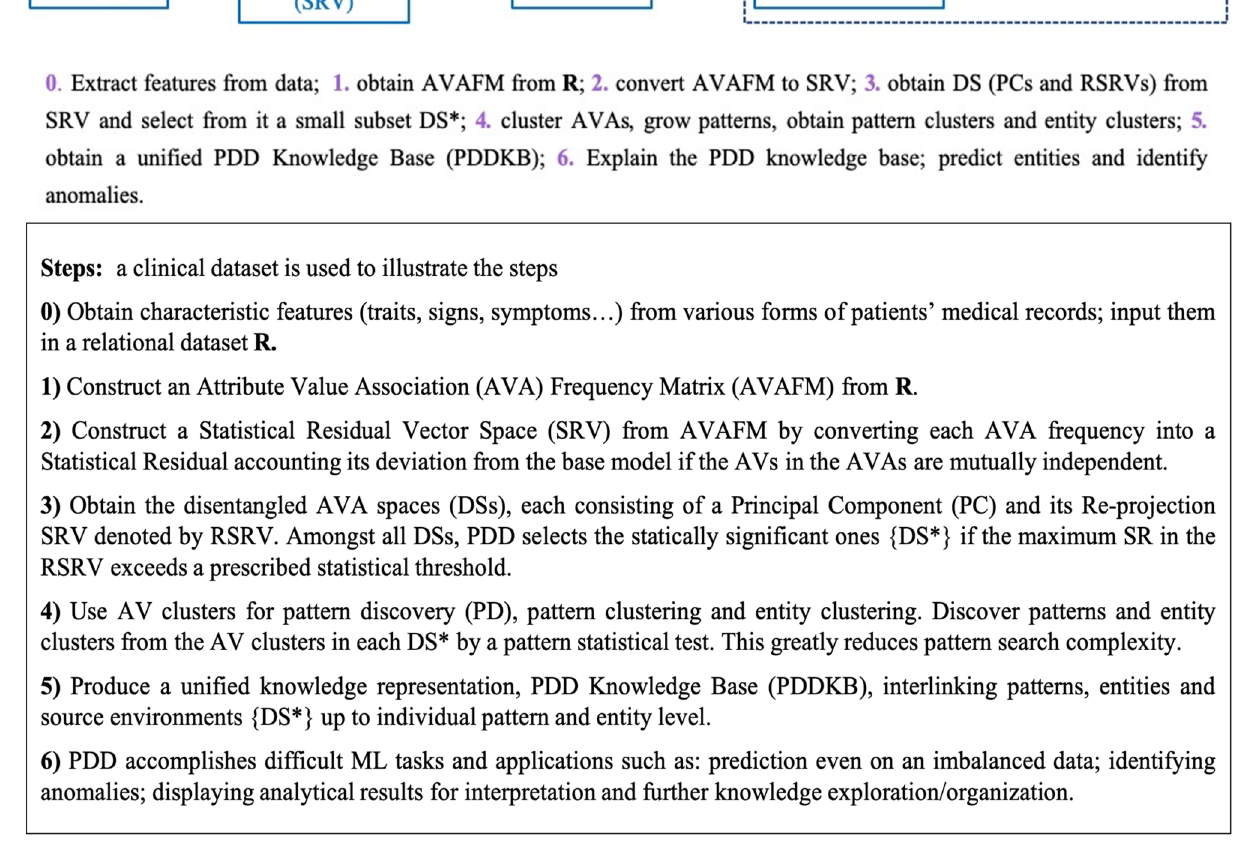
Figure 1. Overview of PDD. The figure describes the key ideas of the new paradigm and the algorithmic steps of